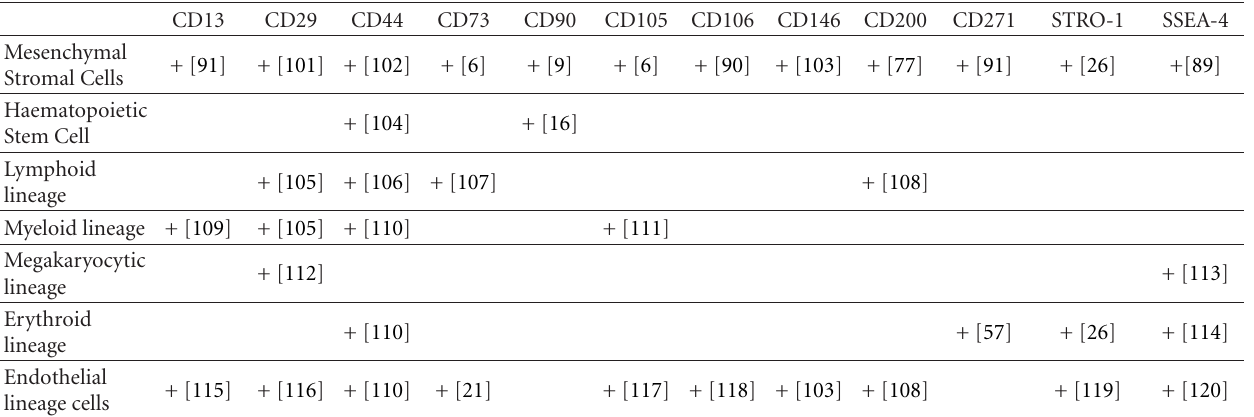
Table 2: Expression of common MSC markers on other cell types found in human bone